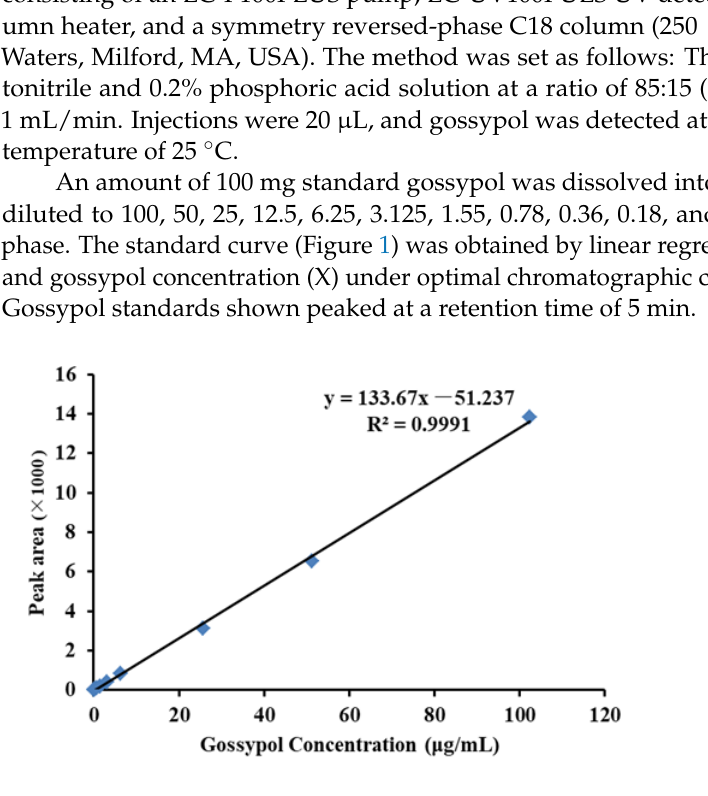
Figure 1. Standard curve of